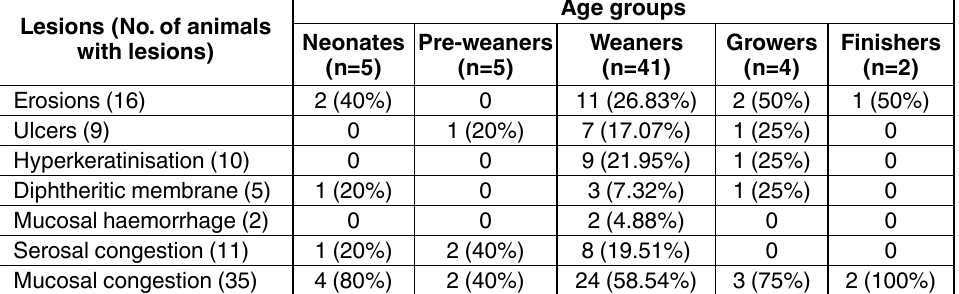
histopathological lesions in stomach comprised of cellular infiltration in lamina propria followed by mucosal necrosis. Gastric mucosa could be considered normal if few inflammatory cells are found in lamina propria with no apparent changes in the glandular and mucosal epithelium (Mendes et al ., 1991). In the present study, the diffused distribution of inflammatory cells varying from mild to intense infiltration with glandular degeneration indicated a significant inflammatory response. Histologically, hyperkeratinised epithelium, mucosal erosions and ulcers of varying degrees of severity were observed and these could be associated with multifactorial etiologies (Cybulski et al. , 2021).